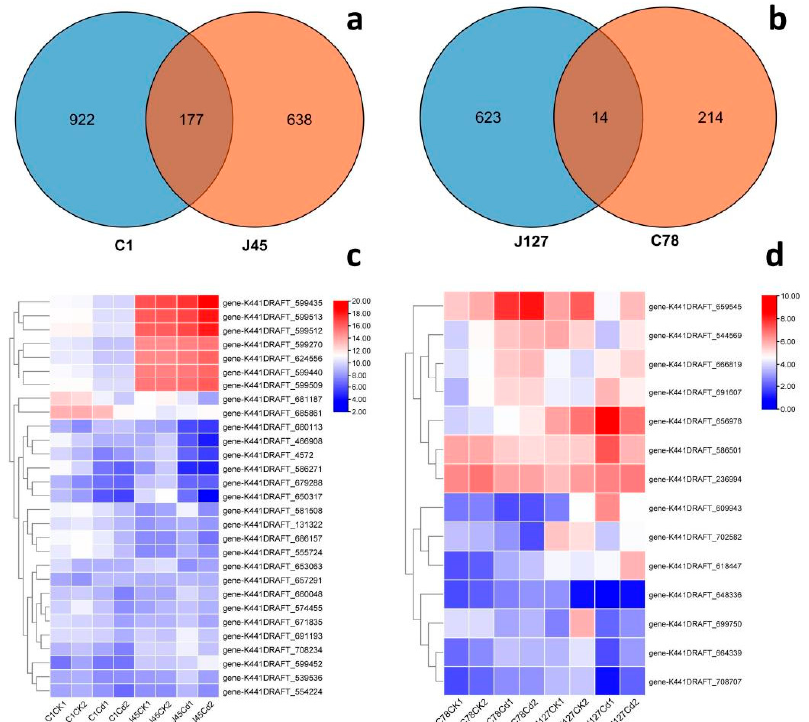
Figure 7. Genome-wide analysis of the DEGs in four strains of C. geophilum after 2 mg/L Cd treatment. ( a ) Venn diagram of total DEGs in two sensitive strains (C1 and J45) of C. geophilum after 2 mg/L Cd treatment as compared to the same strains cultured in normal conditions (0 mg/L Cd). ( b ) Venn diagram of total DEGs in two resistant strains (C78 and J127) of C. geophilum after 2 mg/L Cd treatment as compared to the same strains cultured in normal conditions (0 mg/L Cd). ( c ) Heatmap of parts of common genes for C1 and J45 strains after Cd treatment. ( d ) Heatmap of the common 14 gene for C78 and J127 strains after Cd treatment. The heat map showed a double hierarchical cluster among DEGs (vertical) and samples (horizontal). The different colors of the heatmap, ranging from blue over white to red, represent scaled expression levels of genes with (log2 (FPKM + 1)) across different samples.